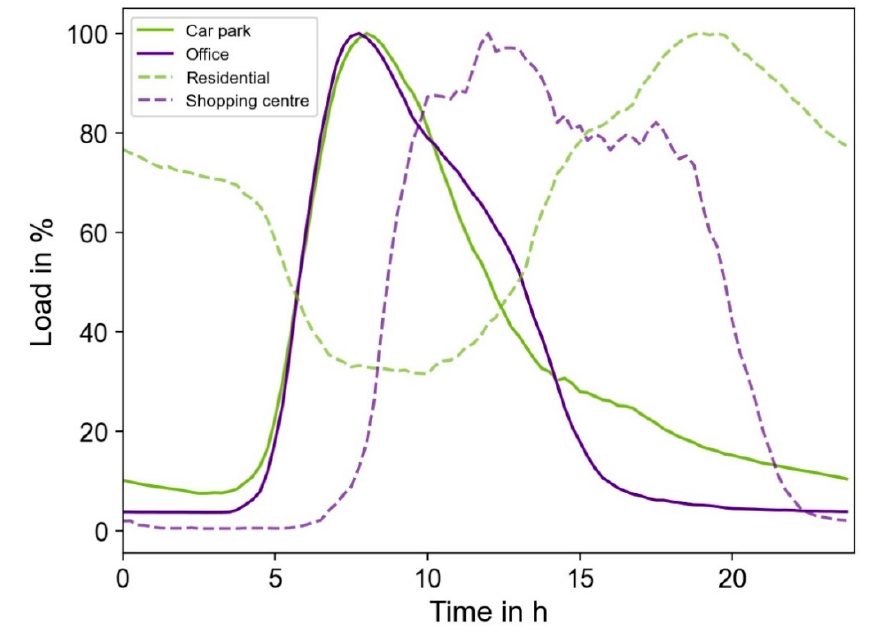
Figure 2. Aggregated average load profiles comparing car parks, offices, and residential charging sites.